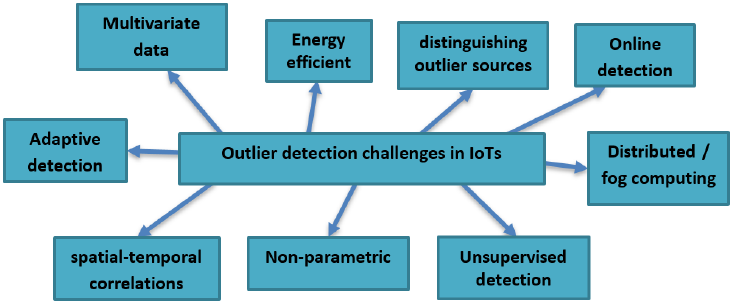
Figure 6. Outlier detection challenges in